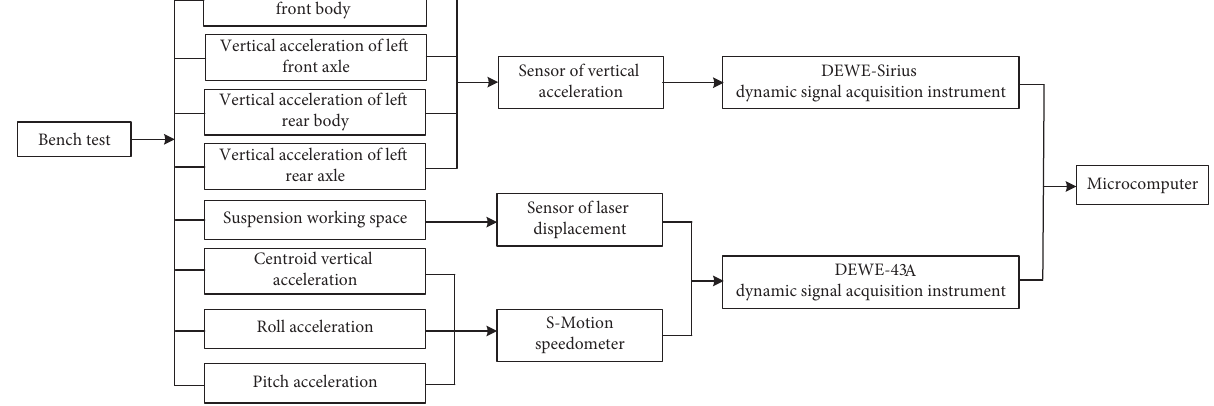
Figure 10: Schematic of data acquisition.